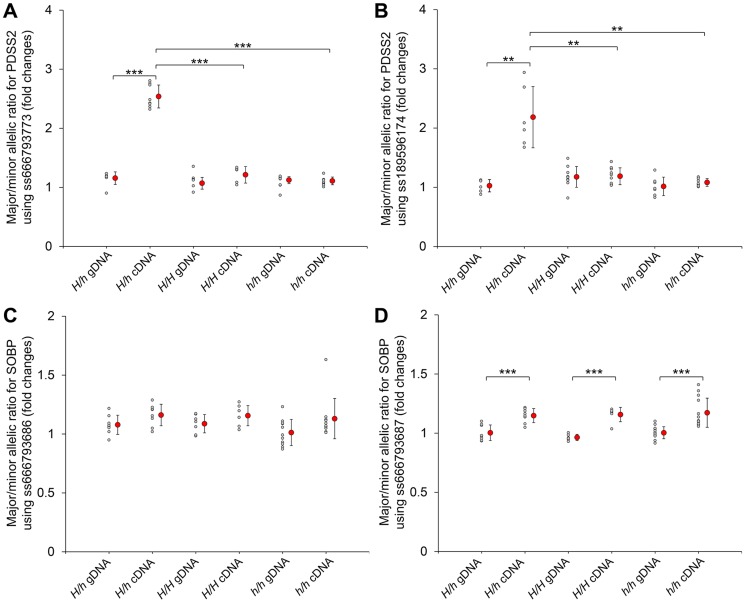
Allelic expression imbalance of PDSS2 and SOBP in skin.The allelic expression imbalance is measured using the pyrosequencing assay. (A and B) The SNPs in the PDSS2 coding sequence correspond to ss666793773 (exon 8) and ss189596174 (exon 6). (C and D) The SNPs in the SOBP coding sequence correspond to ss666793686 (exon 6) and ss666793687 (exon 6). Heterozygous (H/h) and homozygous (H/H and h/h) chickens are tested. The allele with higher expression in cDNA is regarded as the major allele in both genomic DNA (gDNA) and cDNA of the same individual. Small gray circles correspond to the allelic ratio for individual chickens. Large red circles correspond to the average mean value and bar means standard deviation. In homozygous chickens (H/H or h/h), the ratios of three different stages (P60, P130 and P200) are similar and combined into one group for fewer individuals. The P-value of the difference between gDNAs and cDNAs of the same genotype, and cDNAs of different genotypes is evaluated by a t-test. *** indicates P<0.001. ** indicates P<0.01. In (D), the allelic ratios of cDNA do not have difference among the three genotypes, although they are significantly different from the allelic ratios of gDNA. The difference between the cDNA and gDNA may be due to the SNP signal itself.